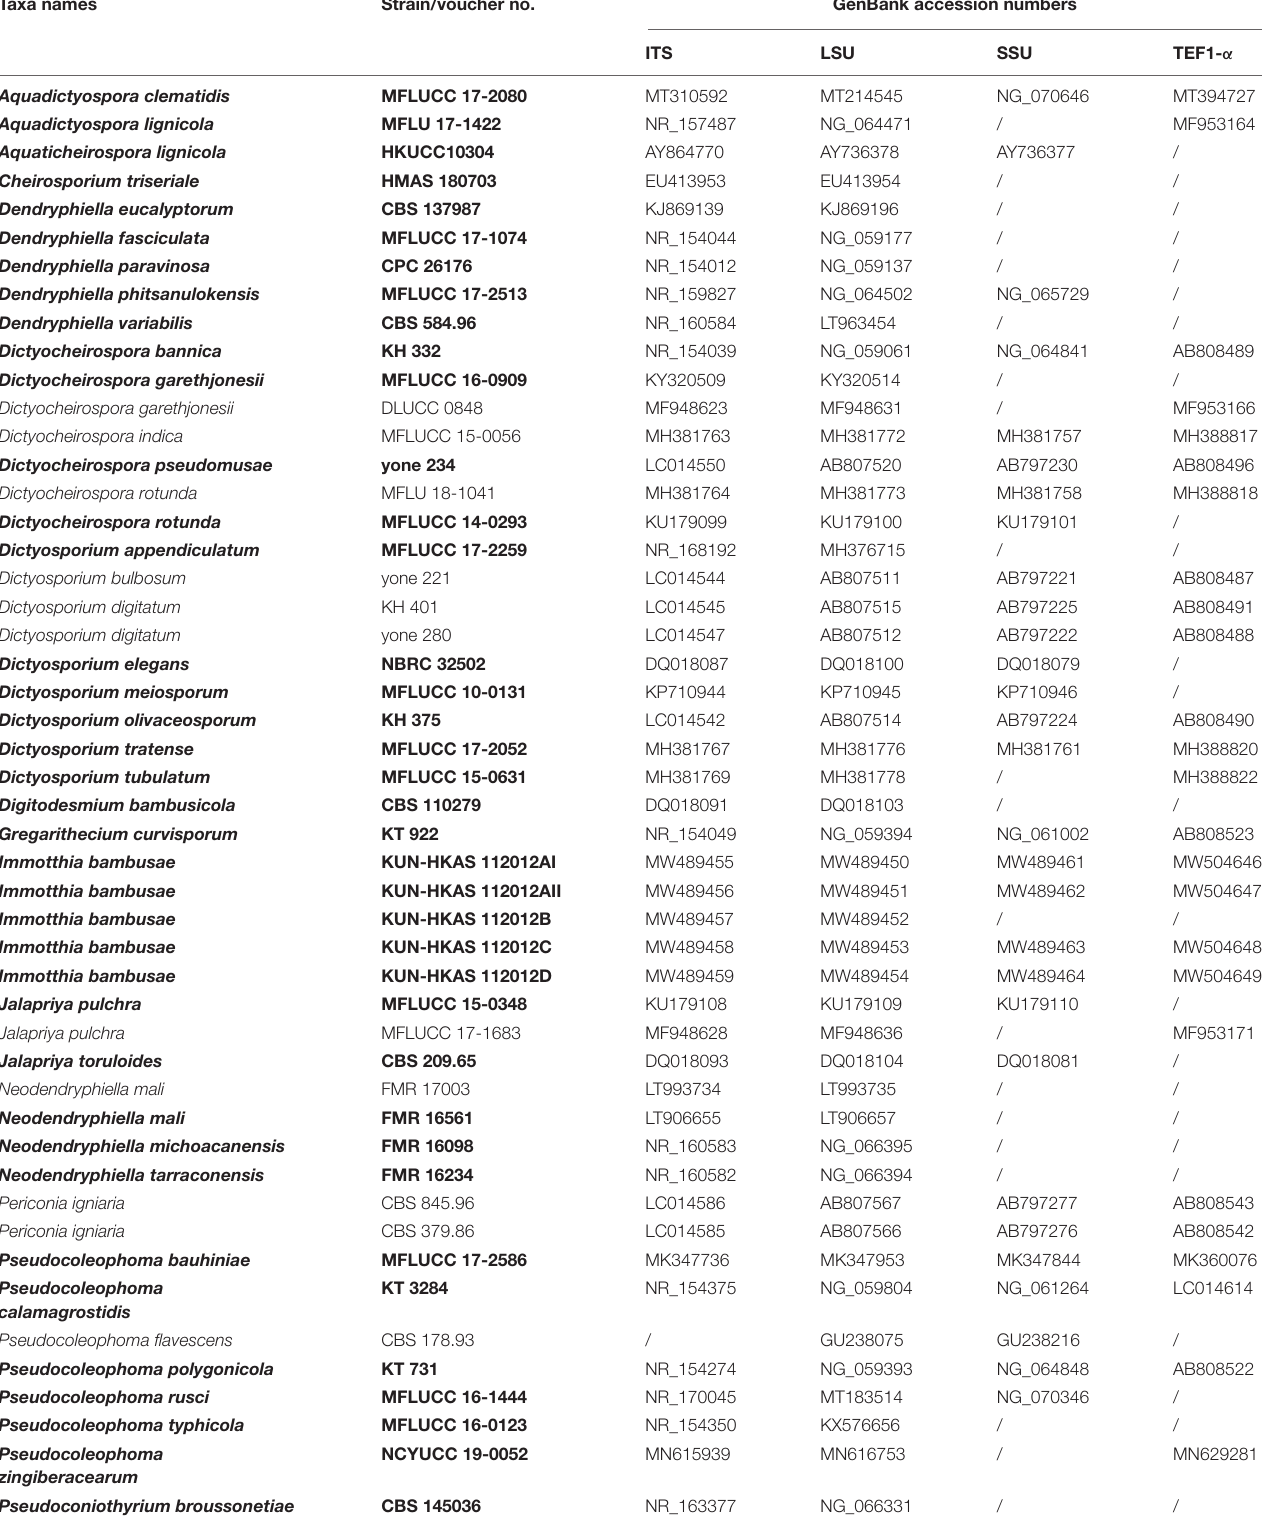
TABLE 1 | Taxa names, strain numbers, and GenBank accession numbers of taxa used for the present phylogenetic